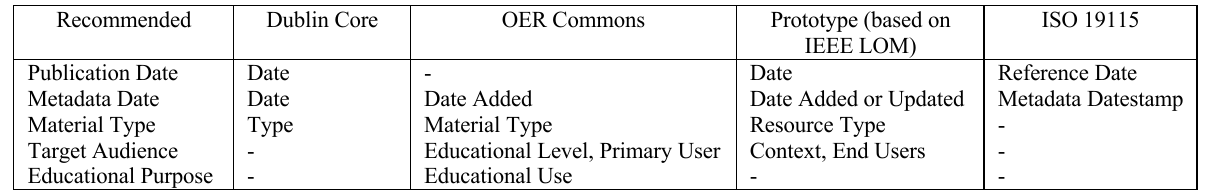
Table 2. Recommended metadata attributes revised for our